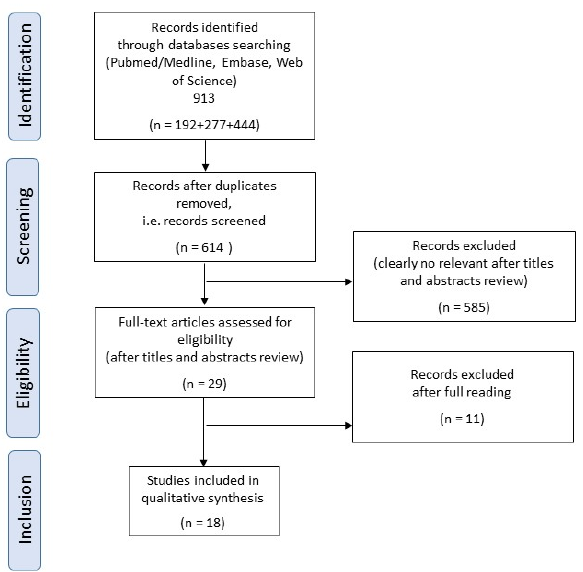
Figure 1. Flowchart describing the search strategy. Several parameters influence the printing of PEEK via FDM technology and, thus, its mechanical properties: the layer thickness [21–26], the nozzle diameter [27], the printing speed [23,27], the printing temperature [22–24,27–29], the chamber temperature [28,30,31], the raster angle [21,24–26,32,33], the build plate orientation [16,24,34,35], the infill rate [35], the PEEK modifications [34,36,37] and the possible post ‐ treatment [25,31,36,38]. Some studies evaluated the surface quality of FDM 3D ‐ printed PEEK elements [24,26,27,36,37]. 3.2. Quality Assessment The results of the assessment of the risk of bias are presented in Table 2 and Figure 2. Among the 18 studies included, 4 exhibited a low risk of bias [35,39–41], 14 showed a moderate risk [21–27,28–31,33–35] and none exhibited a high risk of bias (Table 2, Figure 2). Studies were badly scored in relation to the blinding of the tests and the calculation of sample size or allocation, whereas all studies [21–27,28–34,36–38] except one [35] were found to be adequate in regard to the presence of a control group.